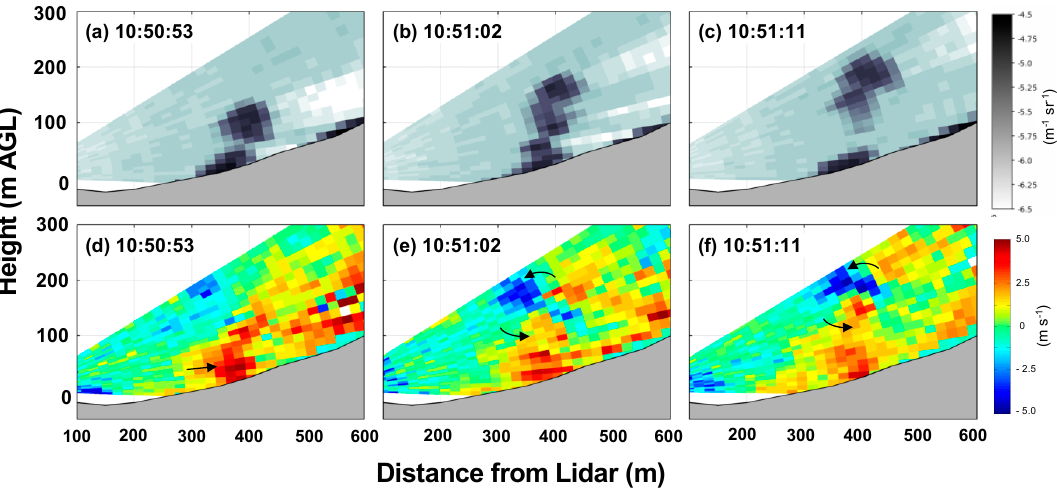
Figure 13. Sequence of RHI scans measured by Doppler lidar showing plume rise. ( a – c ) Smoke backscatter (m − 1 sr − 1 ) and ( d – f ) Doppler radial velocity. Red shading indicates flow away from the lidar (to the right) and blue shading indicates flow towards the lidar (to the left). Solid gray indicates the ground surface along the slope. Times are in PDT.